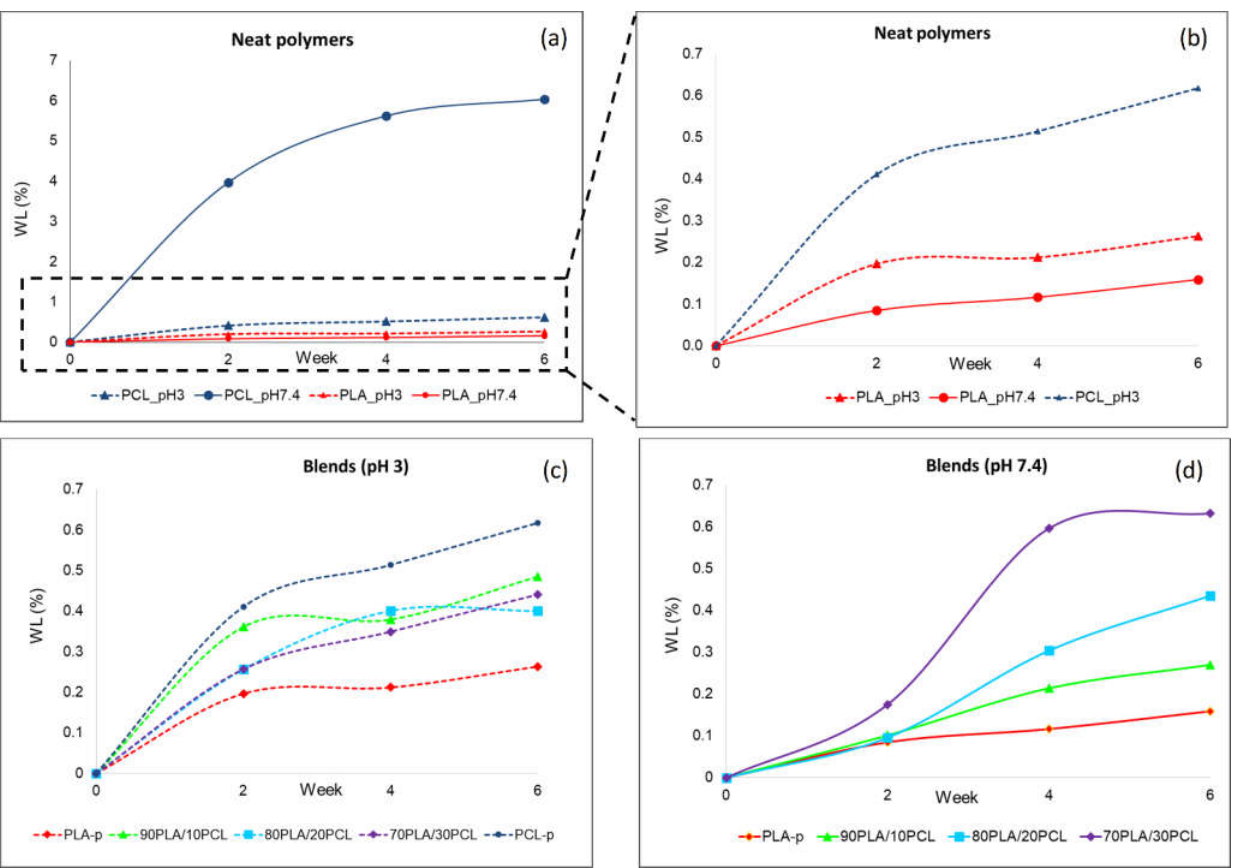
Figure 8. Degradation in terms of weight loss: ( a ) neat polymers, ( b ) extension of neat polymers, ( c ) blend degradation at pH 3, and ( d ) blend degradation at pH 7.4.